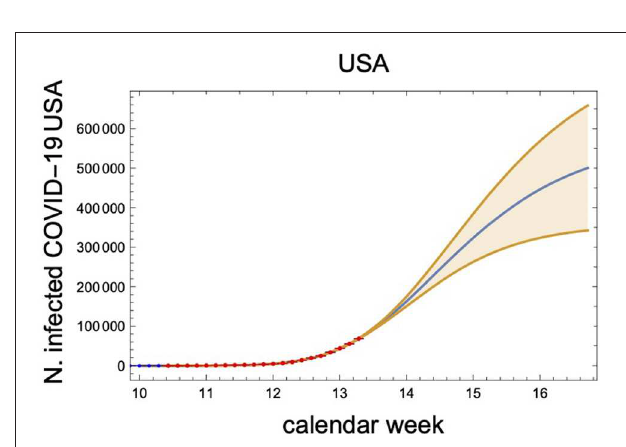
FIGURE 13 | COVID-19 infected cases in the United States as function of the calendar week number. The curve and the band (90% confidence level) have been obtained by performing a fit w.r.t. a , b , and γ to the red data points.